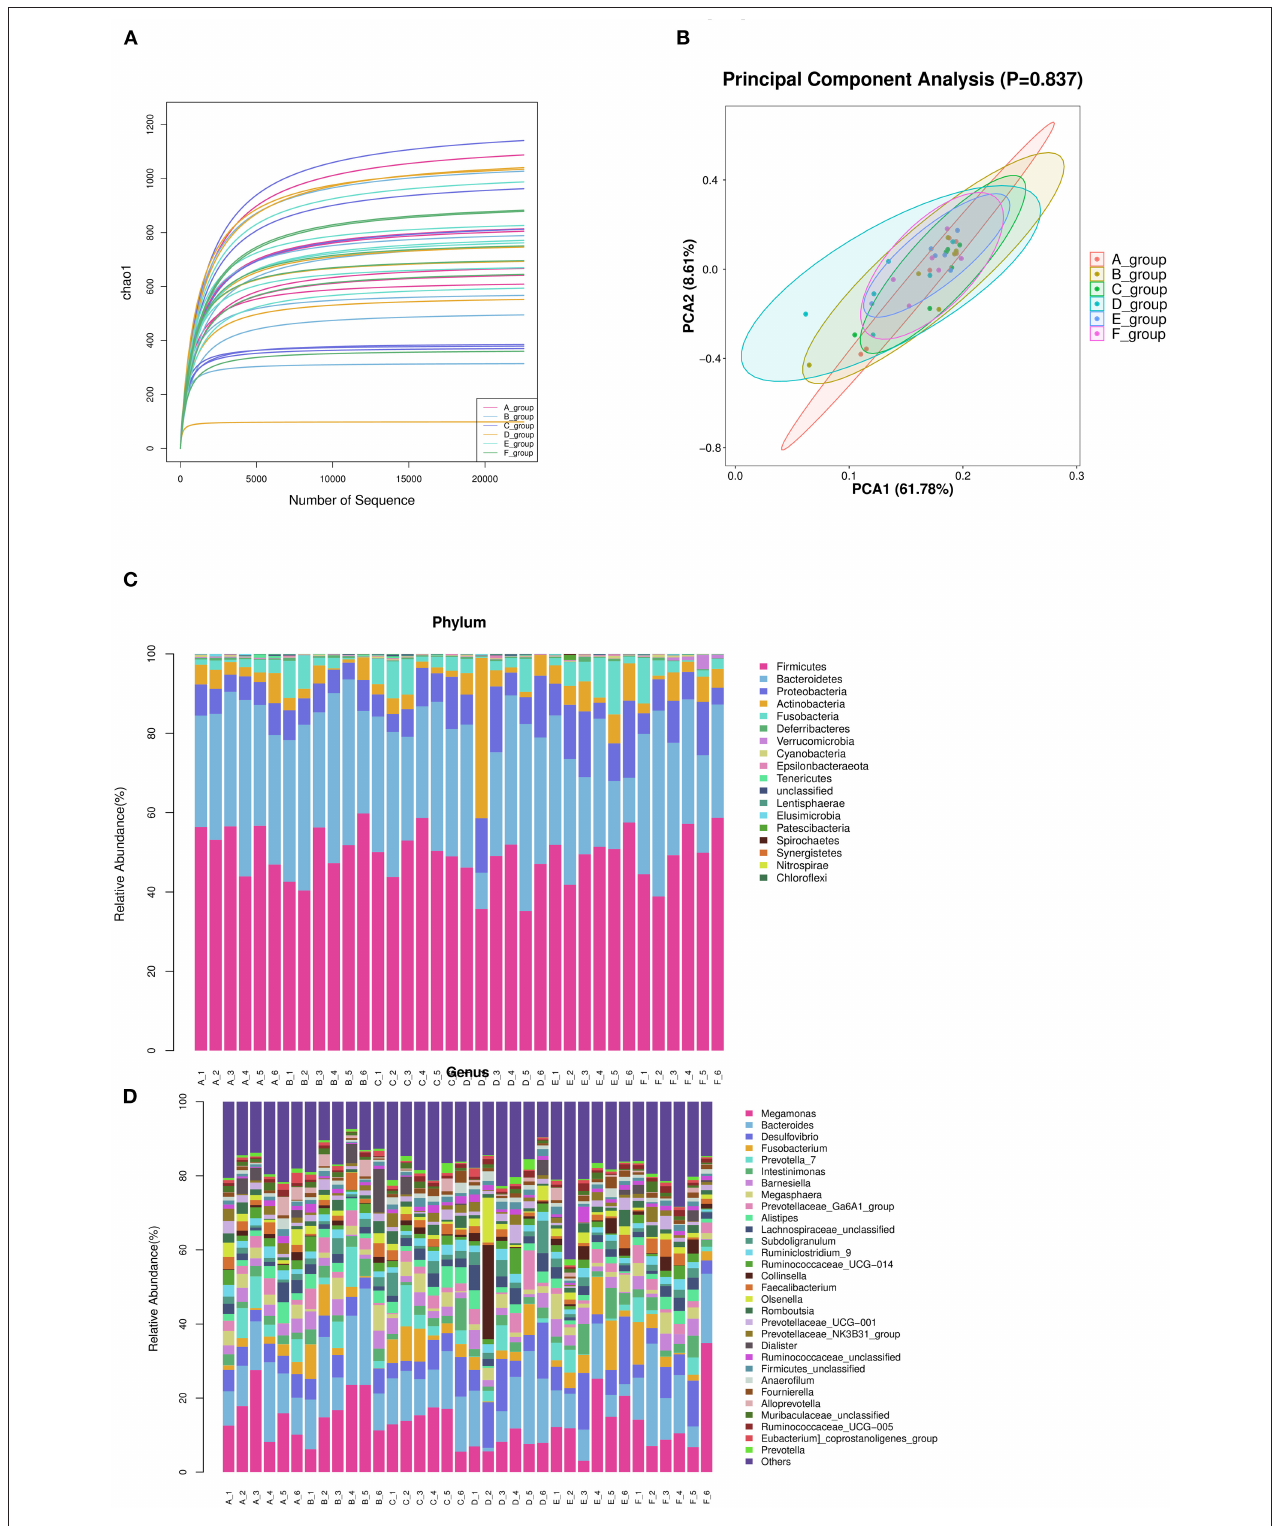
FIGURE 3 | Summary of bacterial taxa in duck cecal digesta observed by concentration of Zn-Met in the diet. (A) The dilution curve was constructed according to the number of randomly selected sequences and the number of observed features. (B) PCA among three groups based on Weighted UniFrac distances. Each point represented a sample. (C) Depicts phylum level classifications for observed features. (D) Depicts genus level classifications for observed features.